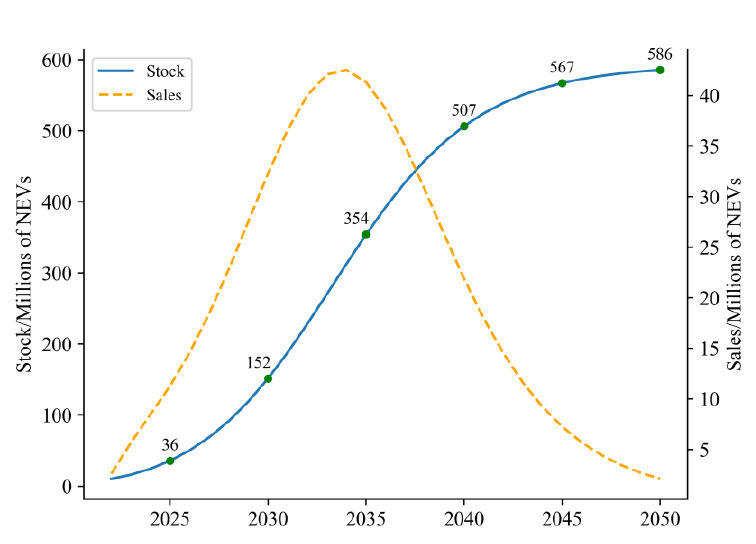
Figure 3. Forecast of NEV ownership from 2025 to 2050.